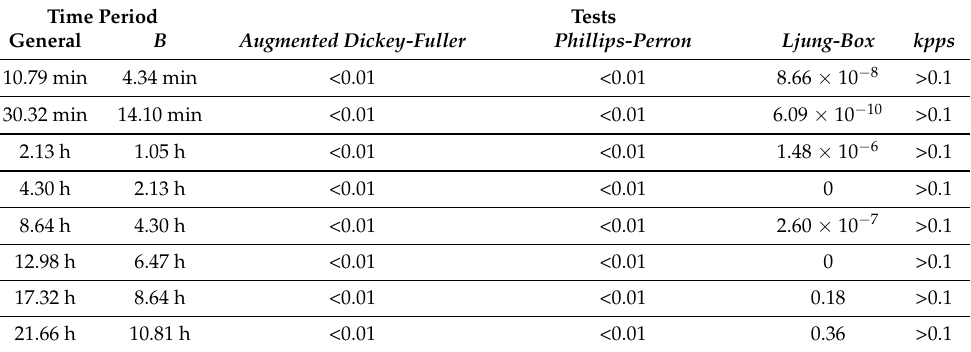
Table 3. Summary of the obtained p -values, for different time periods, for each of the 59 studied datasets under four different stationarity tests: Augmented Dickey-Fuller (first column), Phillips-Perron (second column), Ljung-Box test (third column) and kpps (fourth column). The null hypothesis is of stationarity for the kpps test and of non-stationarity for the other three. For each of the lengths, the minimum p -value value over the studied buoys is displayed for the kpps test and the maximum in the other three cases.